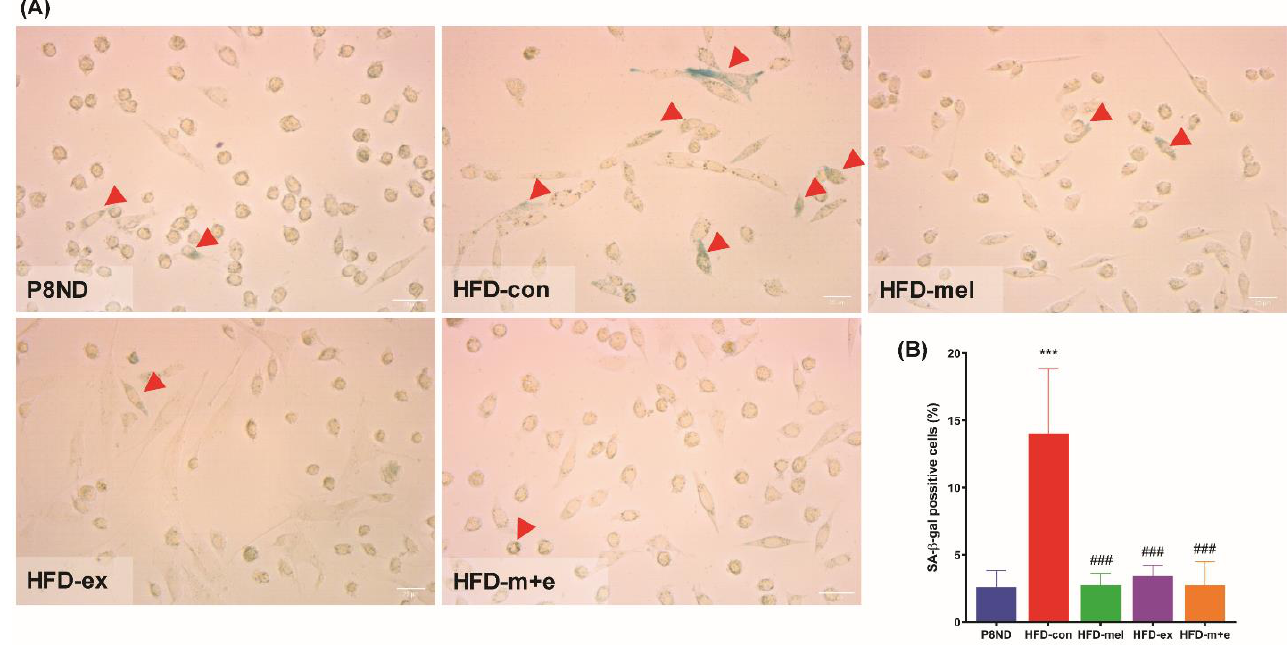
Figure 5. Senescence-associated β -galactosidase (SA- β -gal) in SC-derived primary myoblasts: ( A ) Representative SA- β -gal staining images illustrating SA- β -gal-positive cells (blue) in SC-derived primary myoblasts, and ( B ) the percentage of SA- β -gal-positive cells. Data are the mean ± SD (n = 6 mice per group). Scale bar = 25 µ m; arrowheads indicate SA- β -gal-positive cells; *** p < 0.001 vs. P8ND and ### p < 0.001 vs. HFD-con by unpaired t -test.